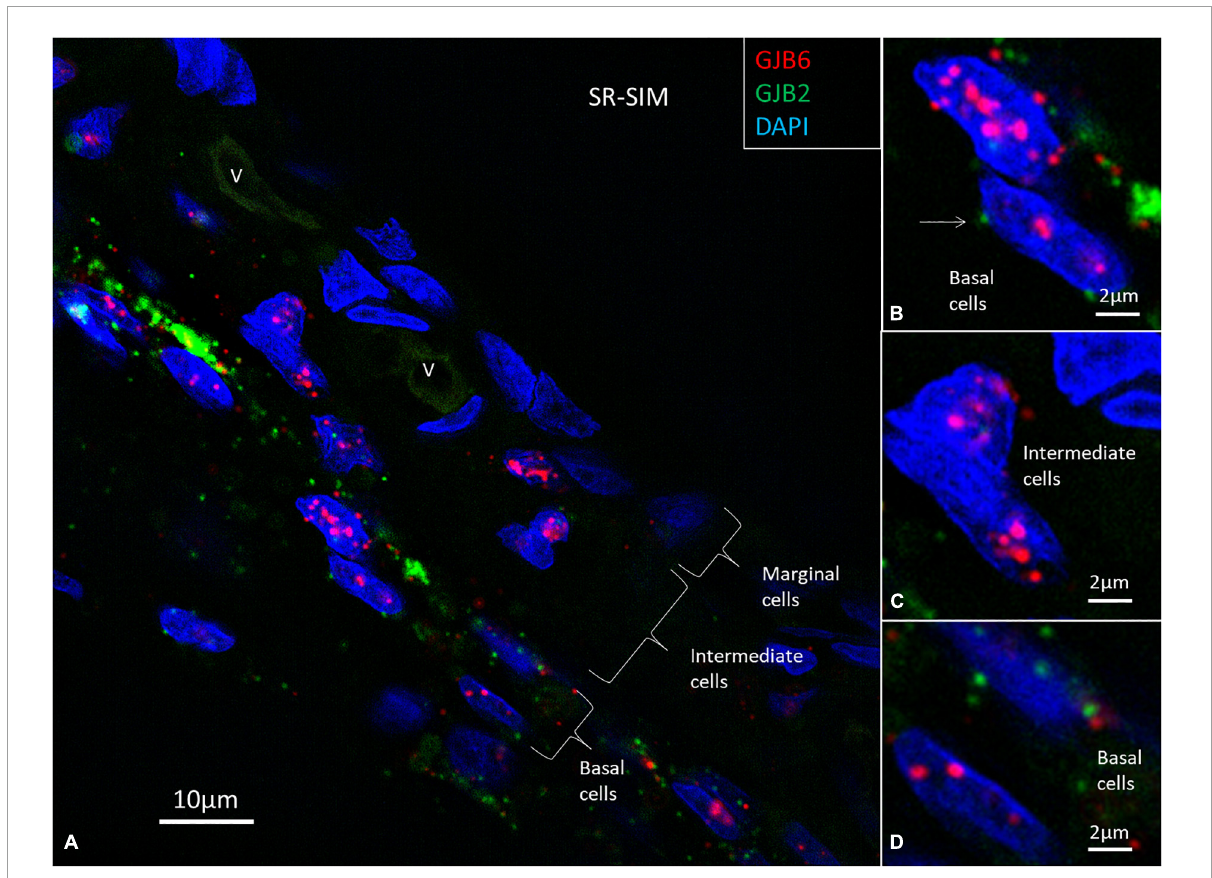
FIGURE9 (A) SR-SIM and multiplex labeling of GJB2 and GJB6 transcripts in the human SV. (B–D) Intermediate cells solely contain GJB6 , while basal cells contain either GJB2 and GJB6 transcripts separately or together in the same cell. This may suggest that GJ plaques consist of GJ channels with different properties and molecular arrangements. V: vessels. Arrow in B shows a perinuclear GJB2 transcript.